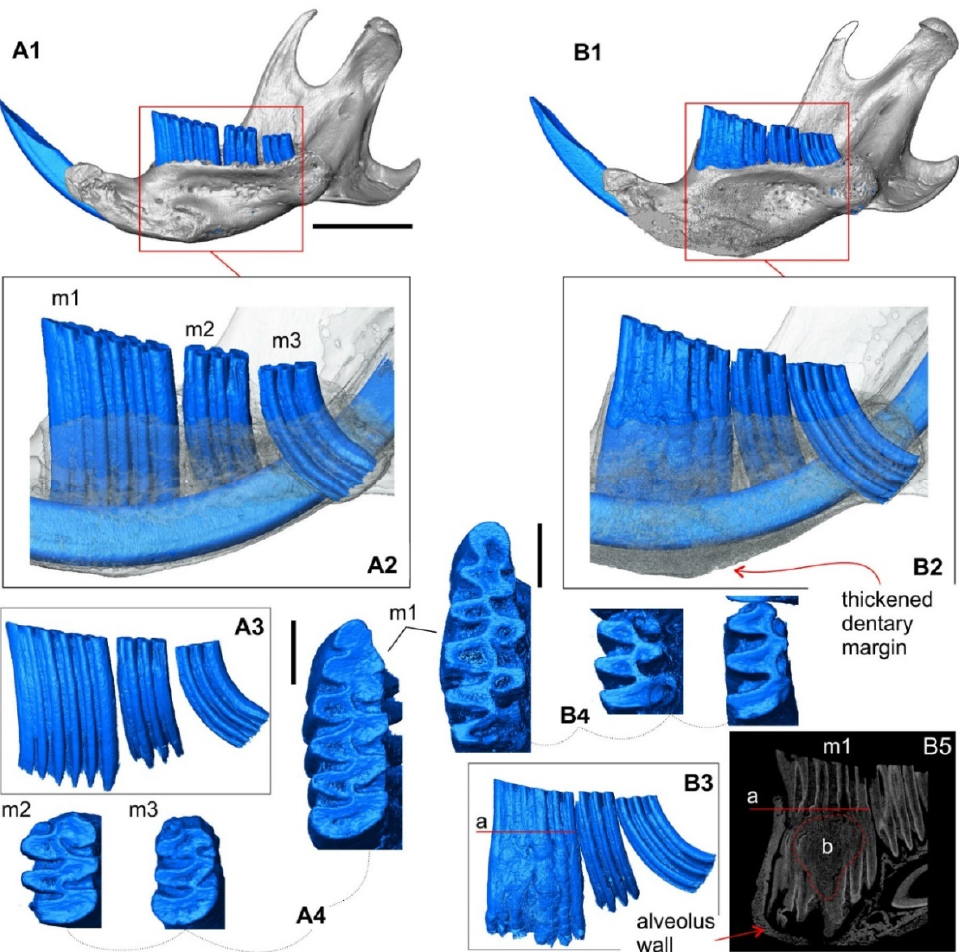
Figure 5. 3D models of the hemimandibles and lower molars (m1, m2, m3) of M. h. ankaraensis (ZIN 98971; A ) and M. hartingi (ZIN 107168-10 from the Eastern Rhodopes; B ). ( A1 , B1 ) Models of the right hemimandibles in medial view. ( A2 , B2 ) Models of the dentary part in transparent view showing molars’ positions. ( A3 , B3 ) Models of isolated molars in medial view. ( A4 , B4 ) Models of lower molars in occlusal view. ( B5 ) An X-ray image of the first molar in parasagittal cut view. Abbreviations. a: the red line shows the approximate border between “normal” prismatic structure of the crown and an “abnormal” part of the crown that lost prismatic structure; b: the red dotted line indicates the part without prisms. The scale bar is 5 mm.